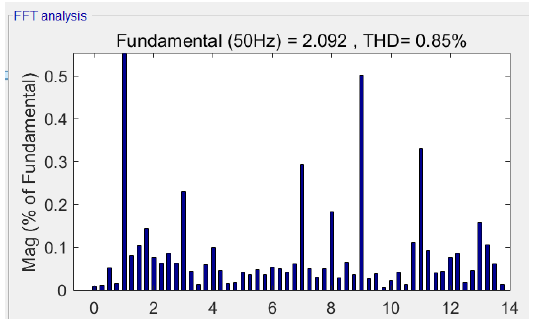
Figure 27. Harmonic characteristics based on the dynamic modulation algorithm at m = 1.0514.